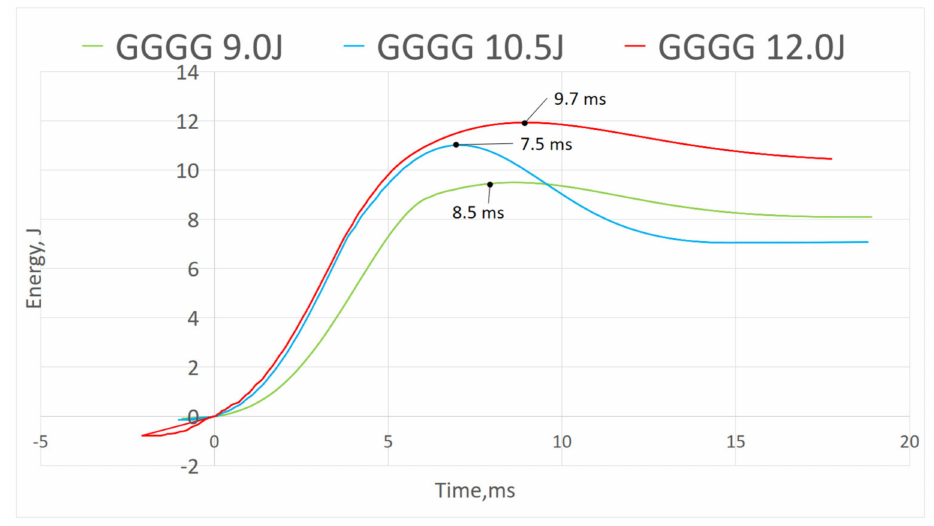
Figure 14. Energy-time of GGGG.